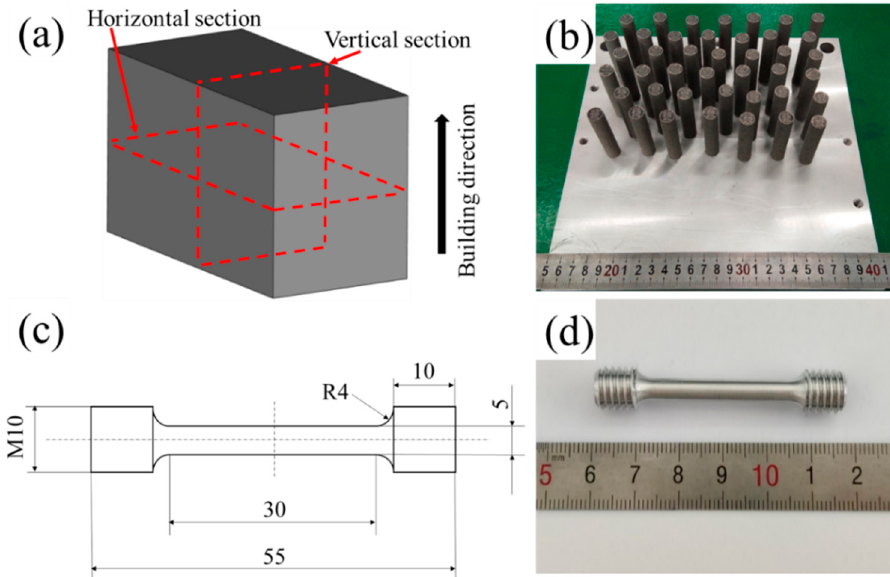
Figure 4. ( a ) schematic diagram of horizontal section and vertical section, ( b ) the blanks of tensile rods, ( c ) schematic diagram of dog-bone rod-shaped standard tensile specimen, ( d ) dog-bone rod-shaped standard tensile specimen.